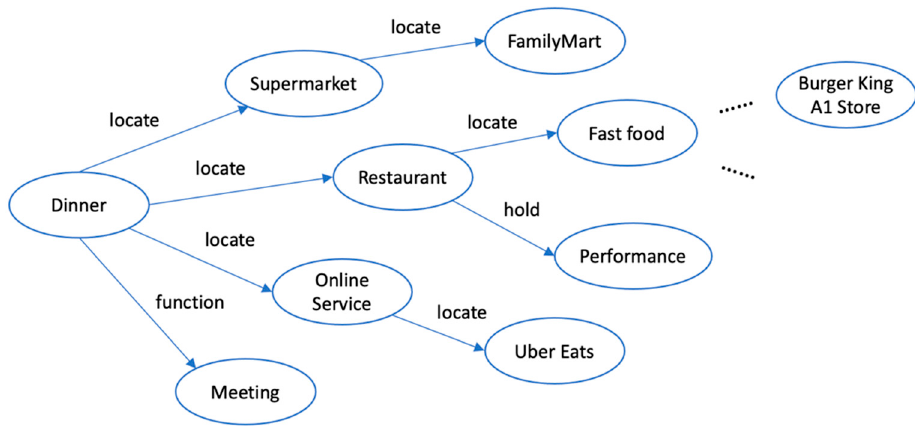
Figure 7. The part of knowledge graph in step 1.